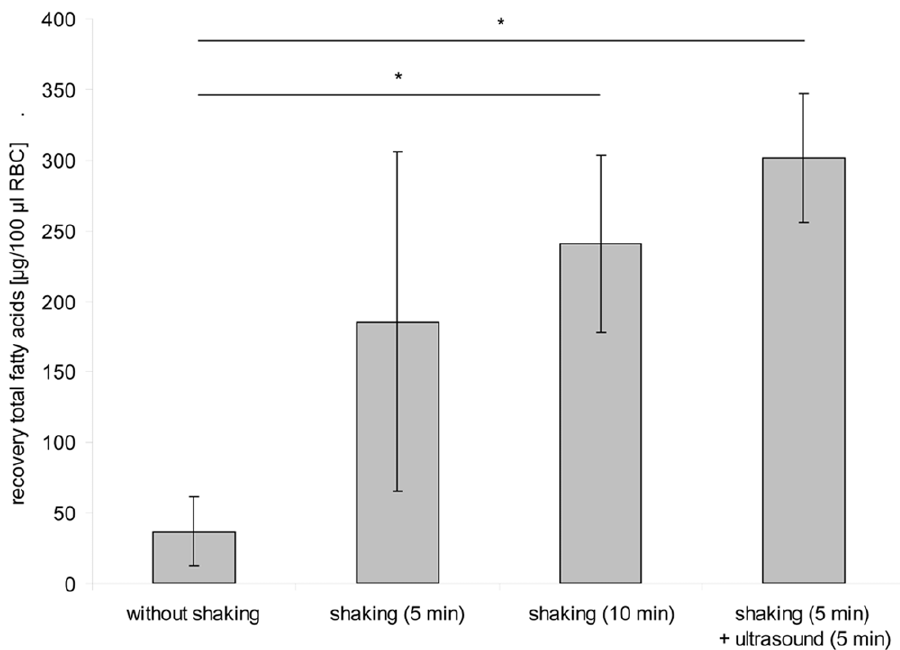
Figure 1. Recovery of total RBC fatty acids using different extraction procedures ( P , 0.05).